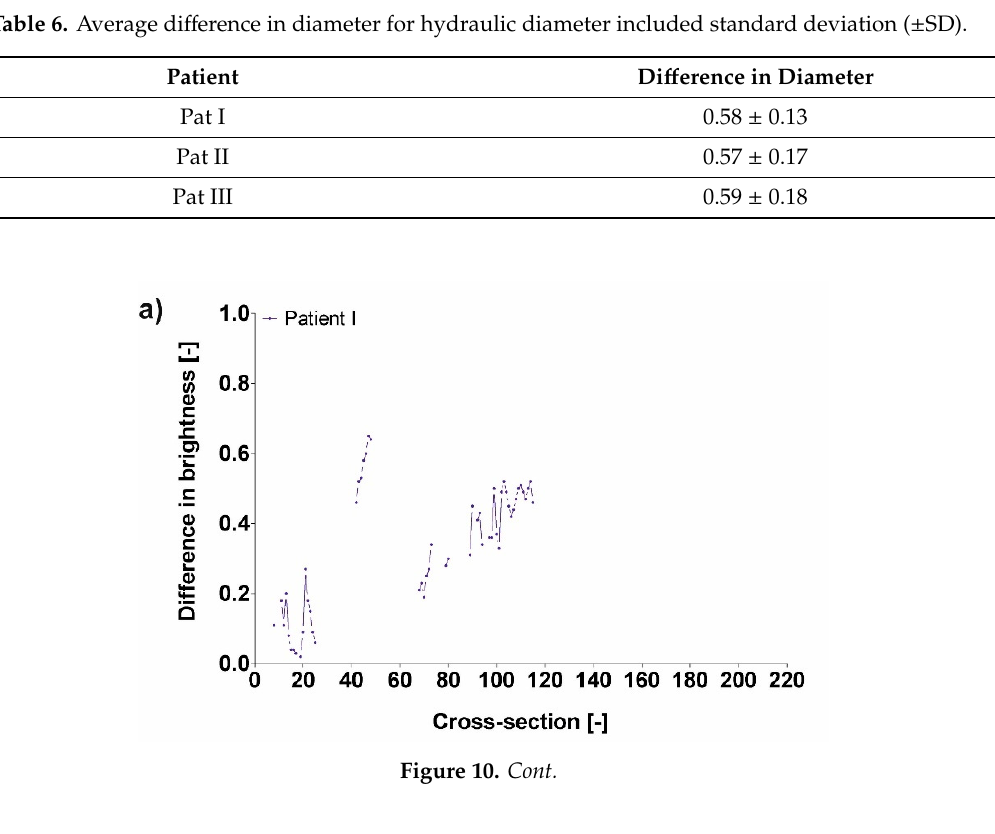
Figure 10. Difference in brightness value for ( a ) Patient I, ( b ) Patient II, and ( c ) Patient III. 4. Discussion The paper presents a new computational approach to standardize the image processing technique for the virtual prediction of blood hemodynamic in the area of aortic acute type B dissection. The novelty of this paper is associated with combination of brightness and diameter analysis to detect changes in blood hemodynamics in true and false channel simultaneously. We investigated how different configuration of aortic duct affects brightness intensity which reflects blood hemodynamic in this area. In our study analysis of Feret and hydraulic diameters, enabled to estimate the effect of changes in flow conditions in the region of false and true lumen connection.